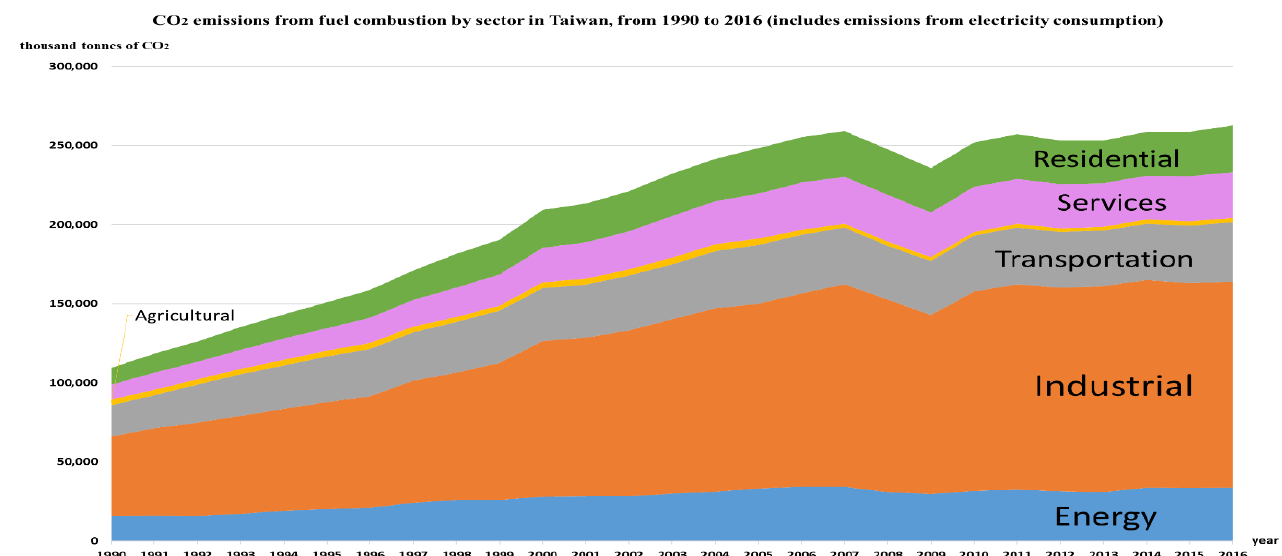
Figure 2. The carbon emission trends in Taiwan during the 1990–2016 period by industrial sector. Source: made by authors.